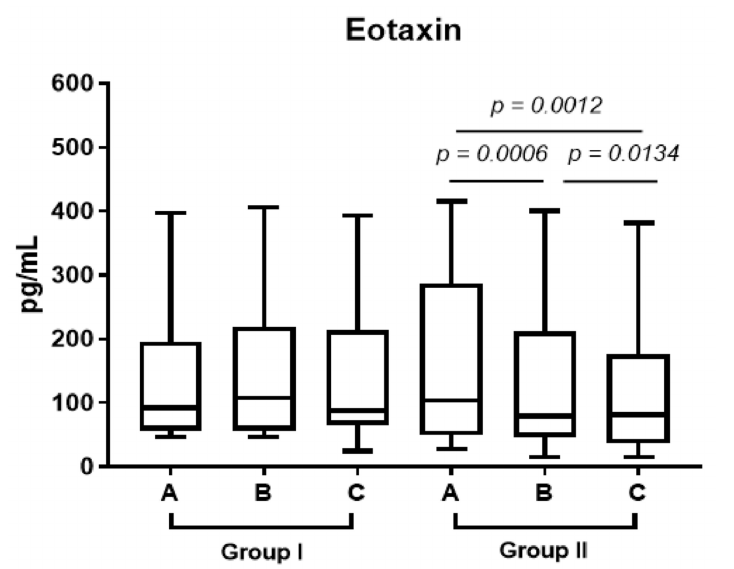
Figure 4. The median level of eotaxin in plasma one week before operation (point A), after admission to the hospital (point B) and 1 month after FESS (point C) in groups 1 and 2.